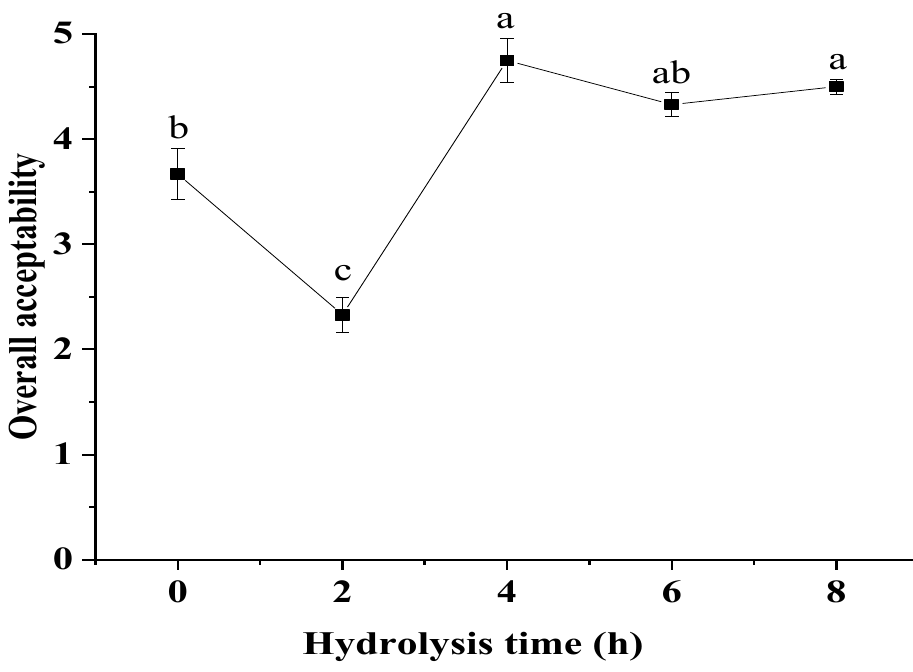
Figure 1. The result of sensory evaluation among MRPs. The values followed by different letters were significantly different ( p ≤ 0.05).